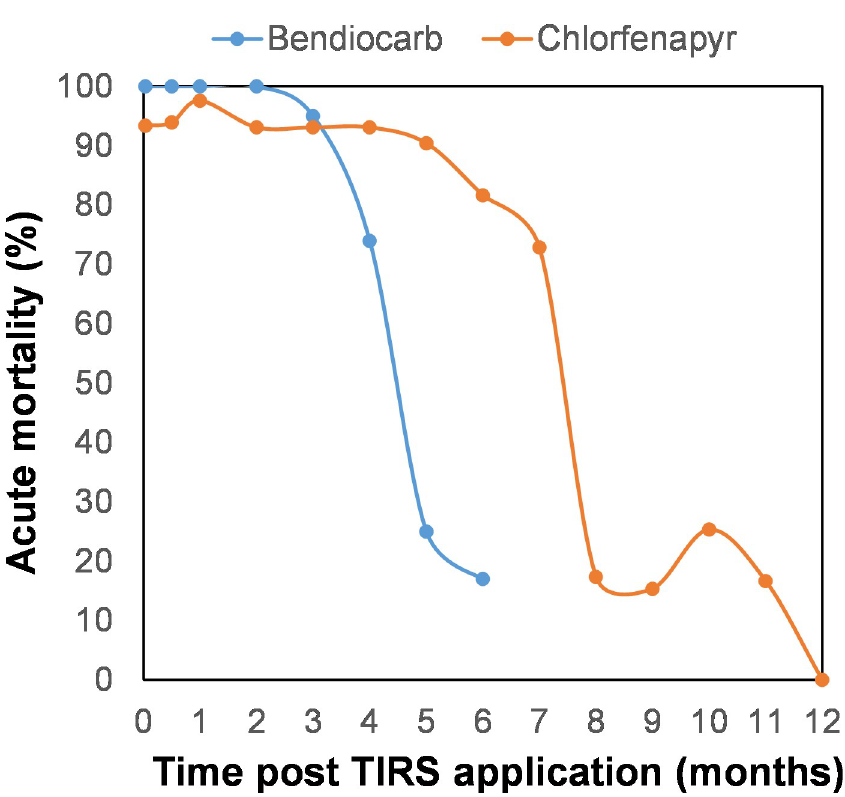
Fig 6. Comparison of acute mortality after TIRS application of bendiocarb (Dunbar et al. [7], blue line) and chlorfenapyr (orange, present study) in experimental houses from Merida, Mexico.